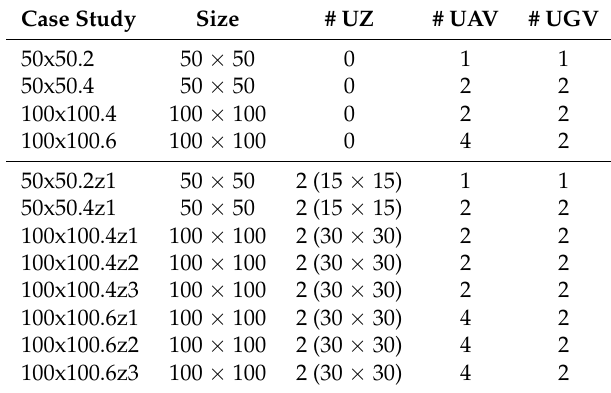
Table 3. Characteristics of the 12 case studies (four without UZs and eight having two UZs). Case Study